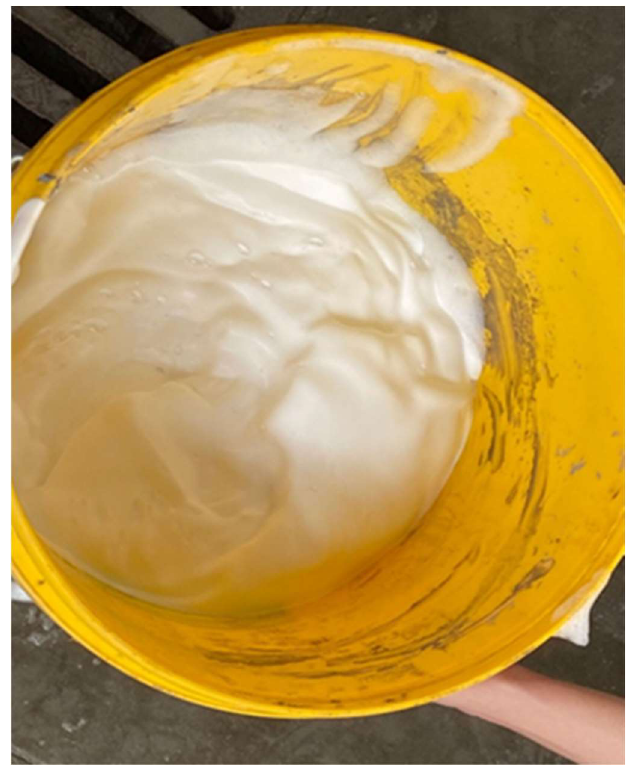
Figure 3. The foam produced by physical foaming with this foaming agent.